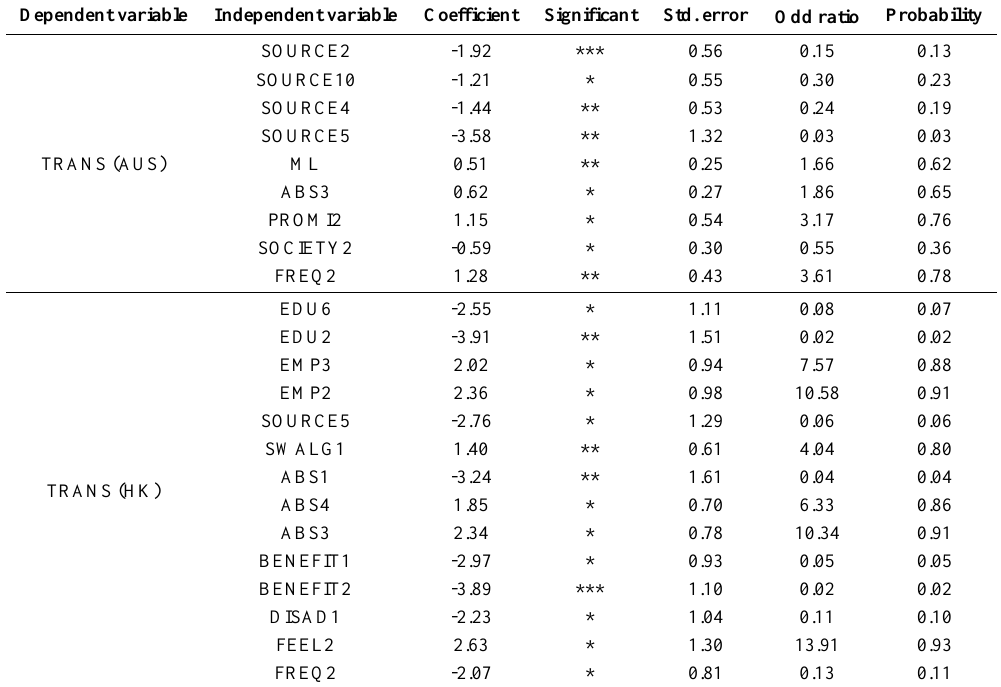
Table B-5. Lack of transparency and community engagement of the AI-based decisions